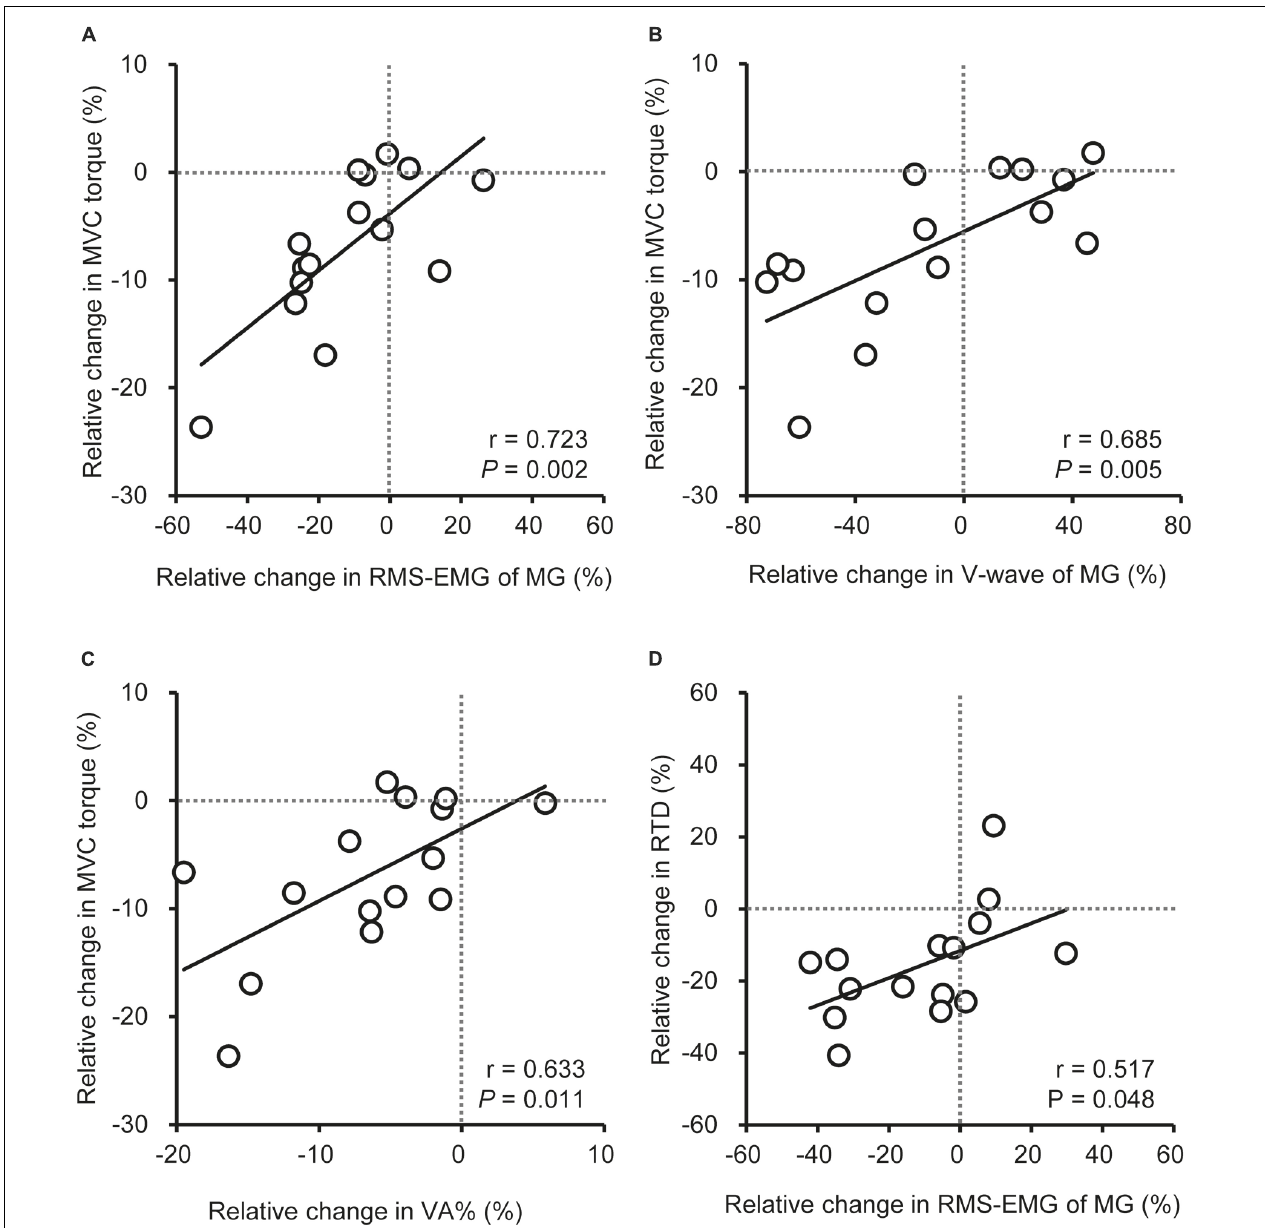
FIGURE 4 | Relationship among vibration-induced relative changes in peak torque during maximal voluntary contraction (MVC, A–C ) of plantar flexion or rate of torque development from the onset to 0–100 ms (RTD, D ) and neural variables [root mean square of the electromyogram (RMS-EMG), voluntary activation (VA%), V-wave] of the medial gastrocnemius (MG) for young men. Data of older men were not included because no significant changes were shown for MVC and RTD after the